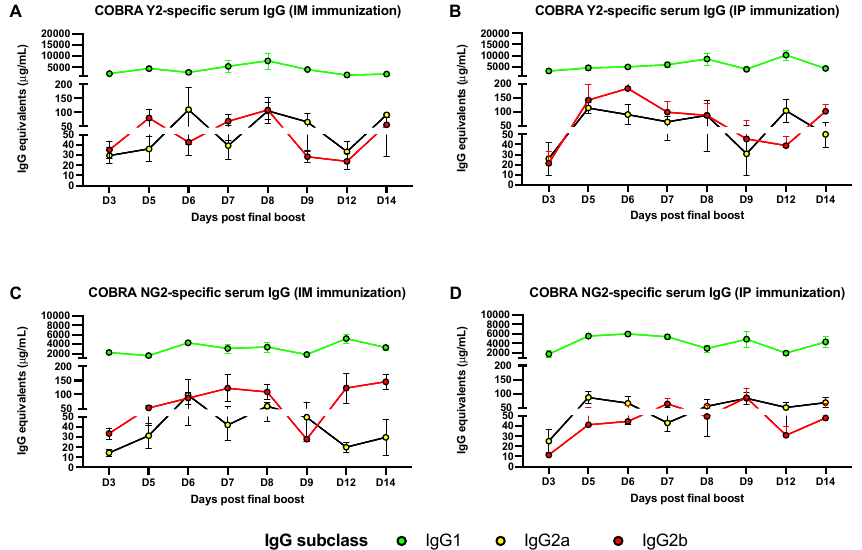
Figure 2. Quantification of Ag-specific IgG1, IgG2a and IgG2b from sera collected at different time points following the final boost of mice that were IM- ( A , C ) or IP-immunized ( B , D ) with the combination of COBRA Y2 and NG2 rHAs. The levels of the different Ag-specific immunoglobulins (IgG1, IgG2a and IgG2b) are expressed as IgG equivalents using a corresponding IgG subclass (IgG1, IgG2a and IgG2b) standard curve. Shown results are expressed as absolute mean values plus standard error of the mean (SEM) (error bars) using the different mouse group sera. The limit of detection of the assay is 0.5 ng/mL of IgG equivalents for each subclass. A synopsis of the statistical analysis comparing the IgG1, IgG2a and IgG2b antibody subclass titers across the different time points is reported in the Supplementary Materials.